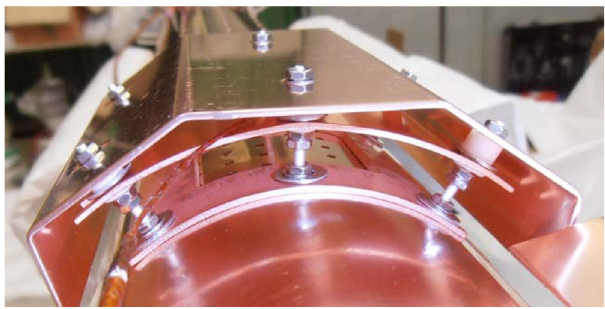
FIG. 4. Picture of a shielded pickup installed in the VPS system. Each pickup is composed of a grounded grid (7% transparency) and a collector polarized at 9 V.